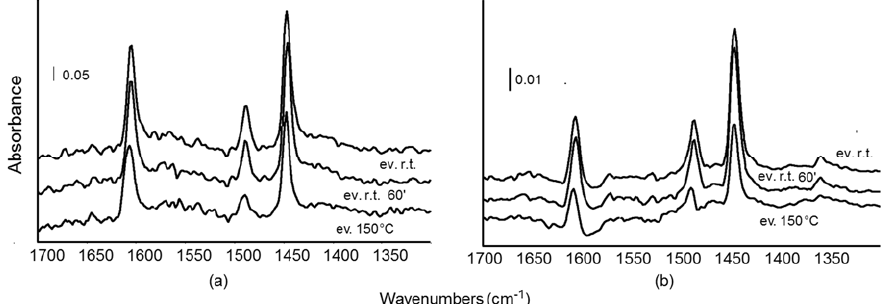
Figure 7. FT-IR subtraction spectra of surface species arising from pyridine adsorption and desorption: ( a ) Over the fresh reference CoO x catalyst and ( b ) over reference CoO x catalyst after pretreatment in 1,2DCP/air in the range 50–500 °C.